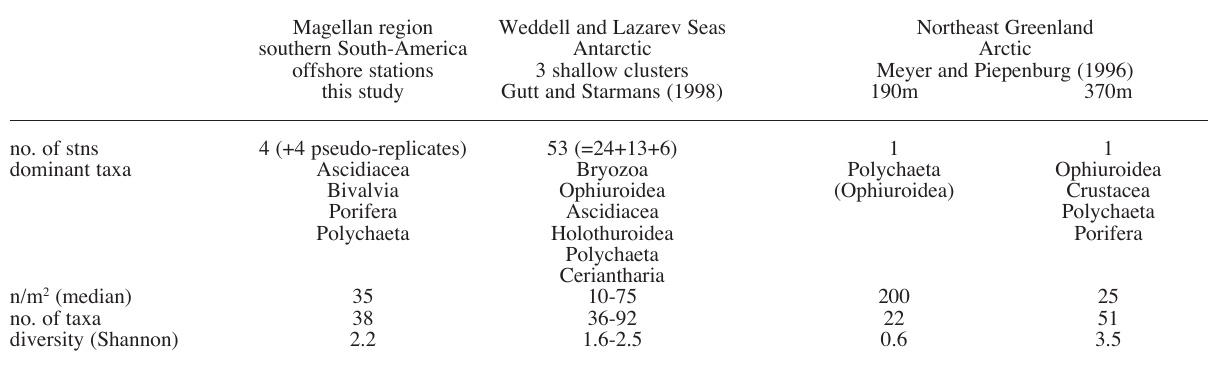
Table 5. Comparison of the results of this study with those from other shelf